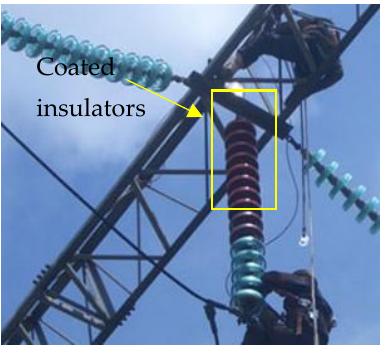
Figure 1. Coated porcelain insulators used on transmission line.